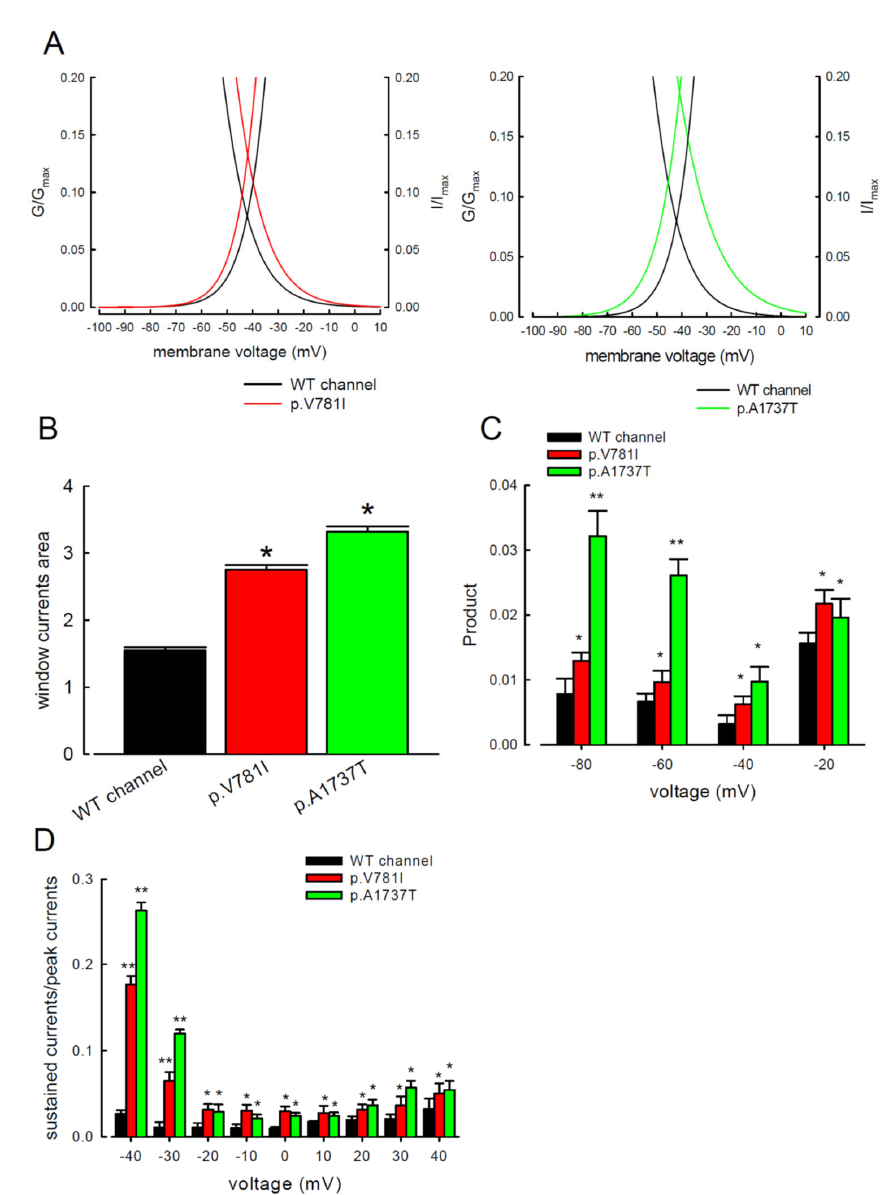
Figure 3. The p.V781I and p.A1737T mutant channels had extensive window currents. ( A ) The black (WT) and colored (p.V781I, red; p.A1737T, green) lines are the zoomed-in portions of the activation and inactivation curves in Figures 1A and 2A. The window currents were calculated in the range between − 100 and +10 mV. ( B ) The area of the window current, which was under the intersection of the activation curve (+10mV) and the inactivation curve ( − 100 mV), was calculated using Python 9.0 [16]. The vertical bar graph shows the integral calculation of the area under activation and inactivation curves of the three channels (* p < 0.05). ( C ) The values of the product of the ratios G/G max and I/I max (activation from Figure 1A multiplied by inactivation from Figure 2A) are plotted against the specific voltage at − 80, − 60, − 40, and − 20 mV in the WT, p.V781I, and p.A1737T mutant channels (* p < 0.05 and ** p <0.01). ( D ) The ratio between the sustained (currents averaged between 90 and 100 ms of the pulse) and the peak transient Na + currents was significantly higher in the p.V781I and p.A1737T mutant channels than in the WT channel (* p < 0.05, and ** p < 0.01).